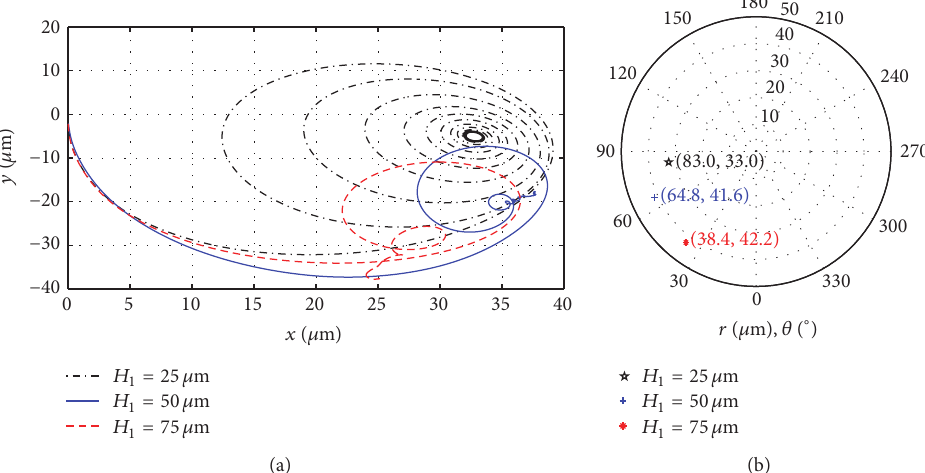
Figure 15: (a) Rotor trajectory and (b) polar coordinates of the HGGJB under different groove depth at the rotating speed of 10000r/min.